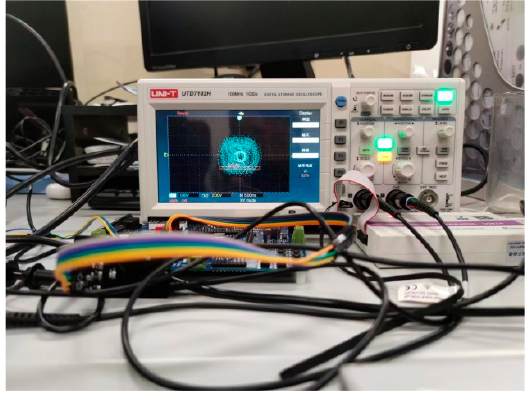
Figure 18. Experimental platform for DSP